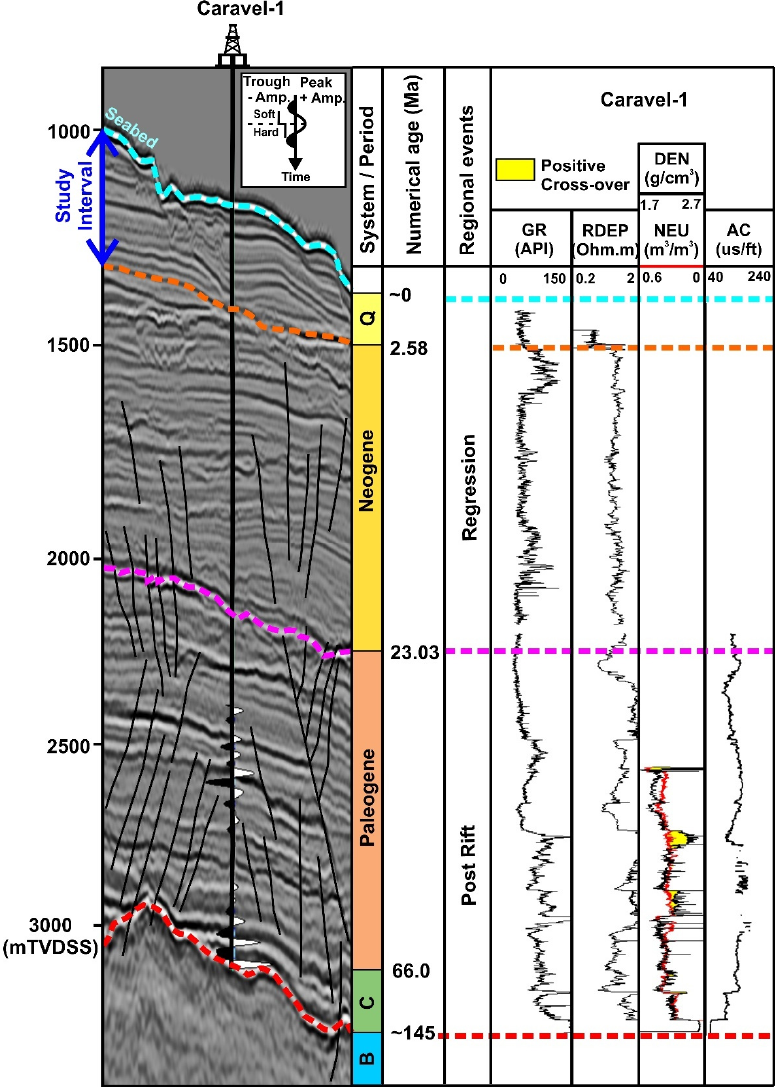
Figure 3. Stratigraphic column of the study area with seismic well-tie of Caravel-1 and regional events taken from O’Leary and Mogg [38] and Wilson, et al. [45]. Q denotes Quaternary; C denotes Cretaceous; B denotes